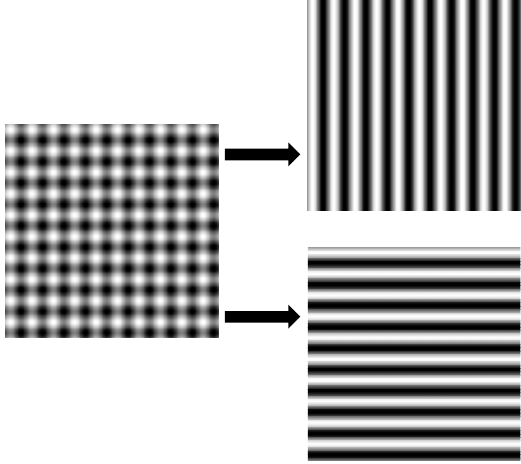
Figure 4. One crossed fringe pattern containing two orthogonal fringe patterns.